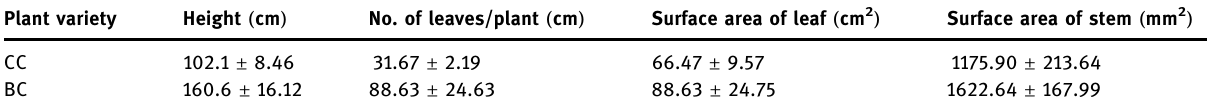
Table 3: Mean values ± SD for plant characteristics at glass dome Plant variety